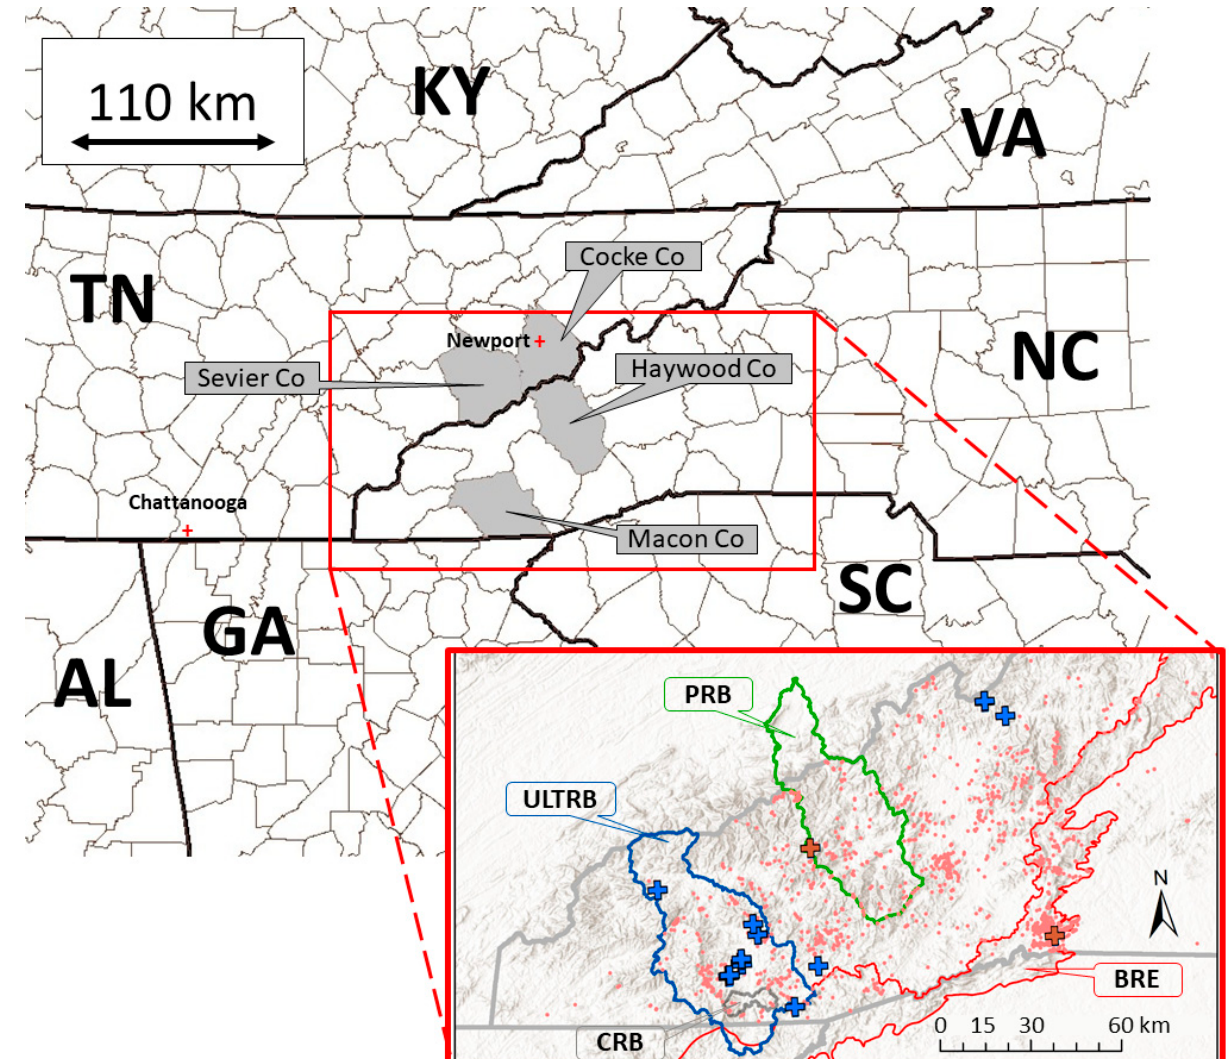
Figure 1. Locations of the Pigeon River Basin (PRB, green outline) and Coweeta sub-River Basin (CRB, gray outline), a sub-basin of the Upper Little Tennessee River Basin (ULTRB, blue outline), and topography (shaded) of the southern Appalachian Mountains. The Pigeon River Basin (PRB) corresponds to the borders of Haywood County, North Carolina and extends northward slightly into Cocke and Sevier Counties, Tennessee. The Coweeta River Basin (CRB) is located in Macon County, North Carolina. Specifics on the locations and elevations of individual rain gauges of the Duke GSMRGN, located in the North Carolina region of the PRB, and CHLRGN, located in the CRB, are provided in Table A1. The center points of the PRB and CRB are located 60 km apart. The Blue Ridge Escarpment (labeled “BRE” and outlined in red) is the boundary between the Blue Ridge and the Piedmont physiographic province. The brown (blue) color-filled “+” symbols highlight two (21) landslide locations documented by the NCGS initiated by the 5–7 February (12–13 April) 2020 heavy rainfall event. Coral dots highlight landslide locations initiated since 1940 not occurring in February or April 2020. Locations of Newport and Chattanooga, Tennessee are also highlighted with a red “+” symbol.